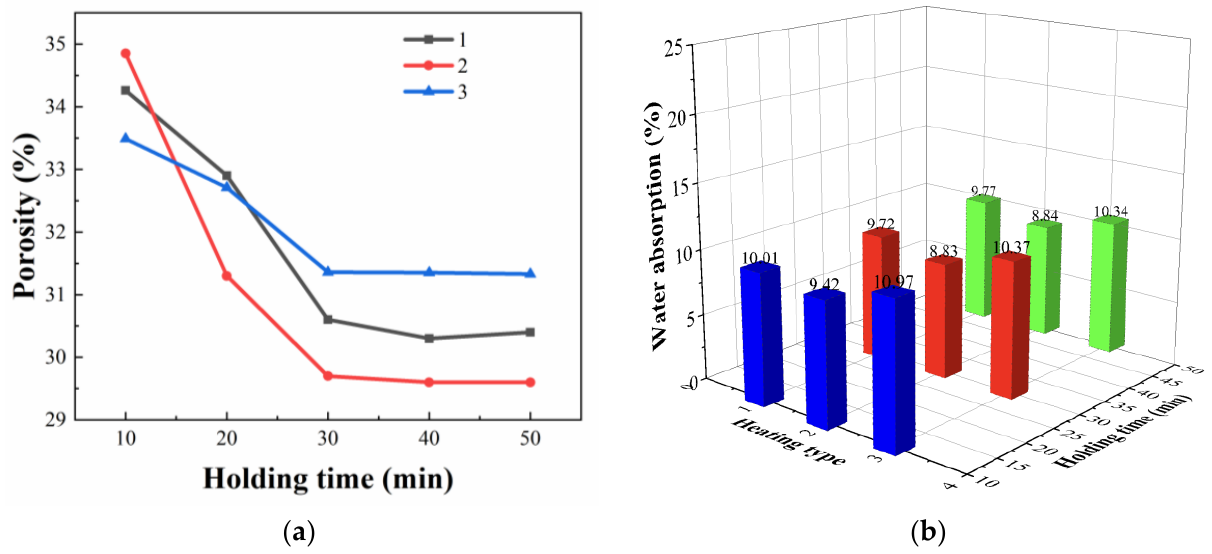
Figure 12. Effect of sintering temperature on water absorption of MGS sintered brick.